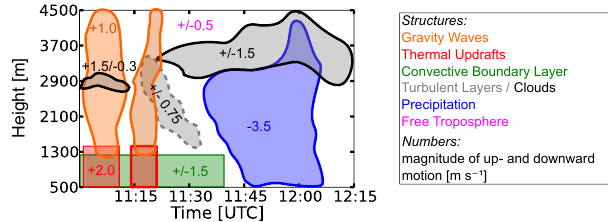
Figure 6. Features of vertical velocity are collected from the area marked in Fig. 3 with a black dashed box. The magnitude of de- tected vertical velocities is indicated with numbers, the different colors indicate different features described in the legend (Bühl,